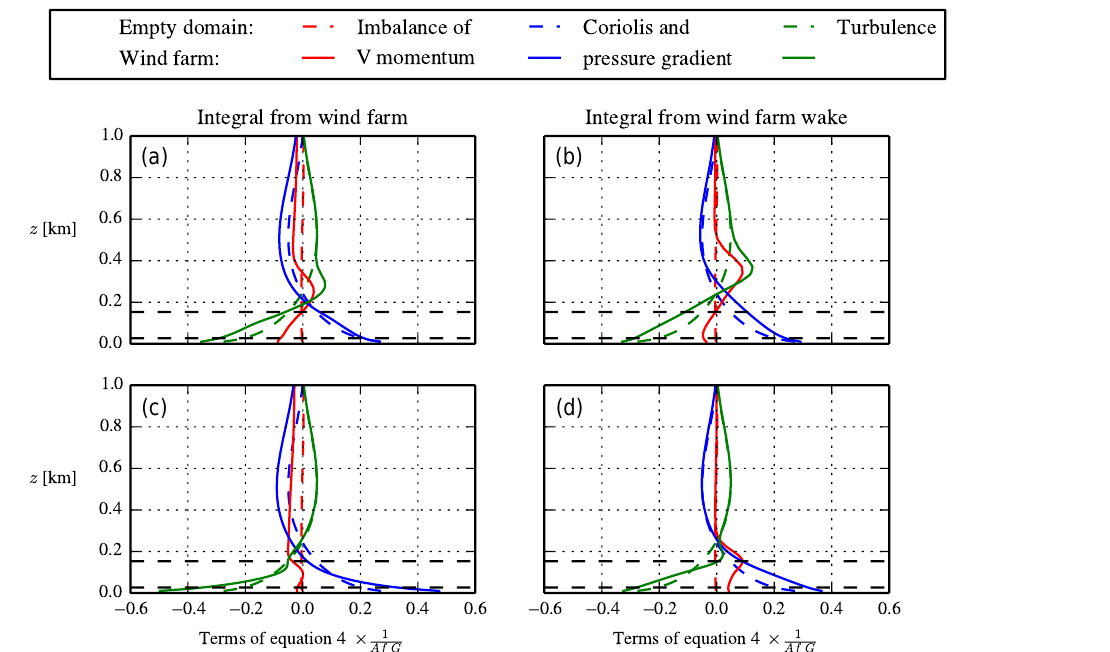
Figure 7. V -Momentum balance. (a, b) Wind farm represented by 25 ADs, where rotor area is shown as black dashed lines. (c, d) Wind farm represented by a high roughness. (a, c) Integral taken from wind farm area. (b, d) Integral taken from near wind farm wake. Dashed lines represent the results from an empty